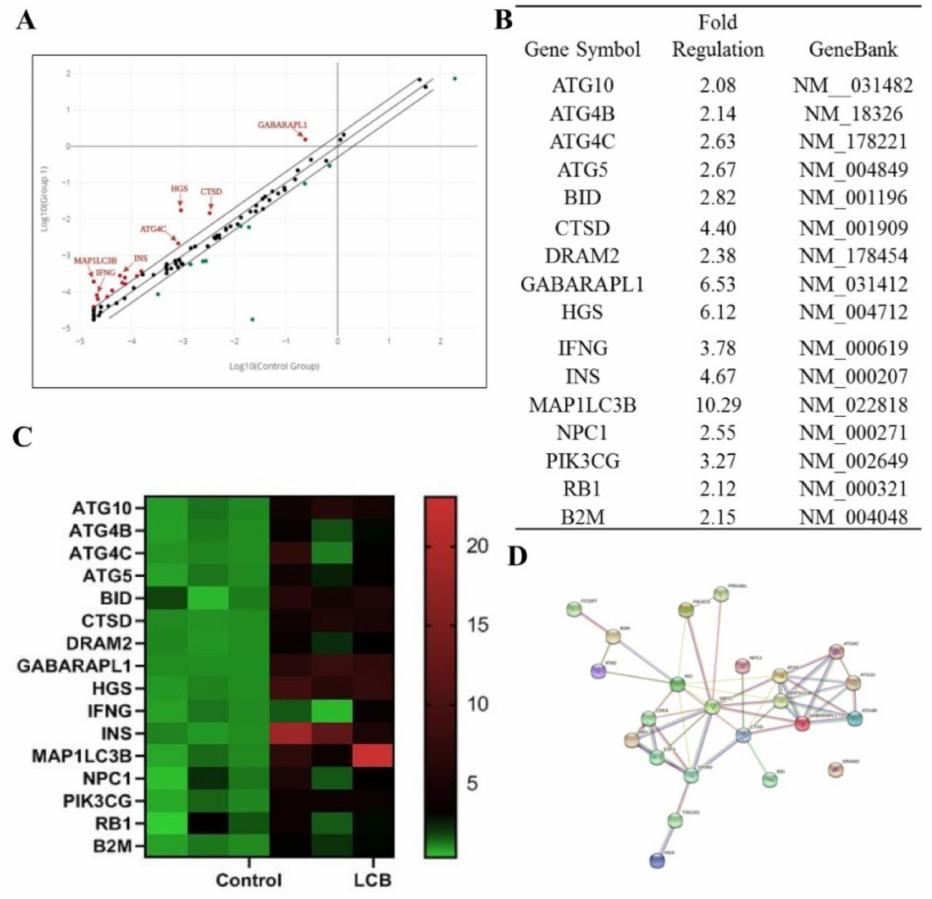
Figure 6. RT–PCR array on the gene expression level of autophagy-related genes in SH–SY5Y cells with or without 20 uM LCB-treatment for 24 h. ( A ) Scatter plot and ( B ) table showing the gene expression level of SH–SY5Y cells under control or LCB treatments. ( C ) Heap map and ( D ) STRING database predicted differential autophagic genes and its possible pathway on AMPK/SIRT1 activation upon LCB